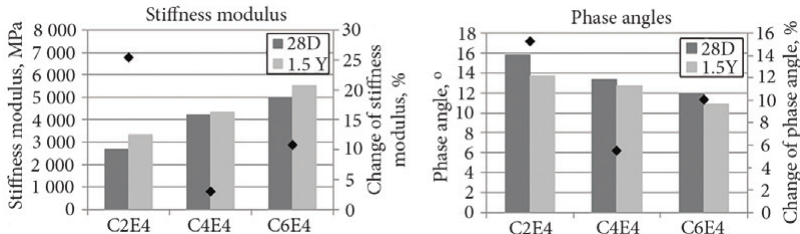
Figure 5. Stiffness modulus and phase angles of C2E4, C4E4, and C6E4 Mineral-Cement-Emulsion mixtures (frequency 10 Hz, temperature 20 ° C), bars represent the values obtained from laboratory tests, dots represent the relative